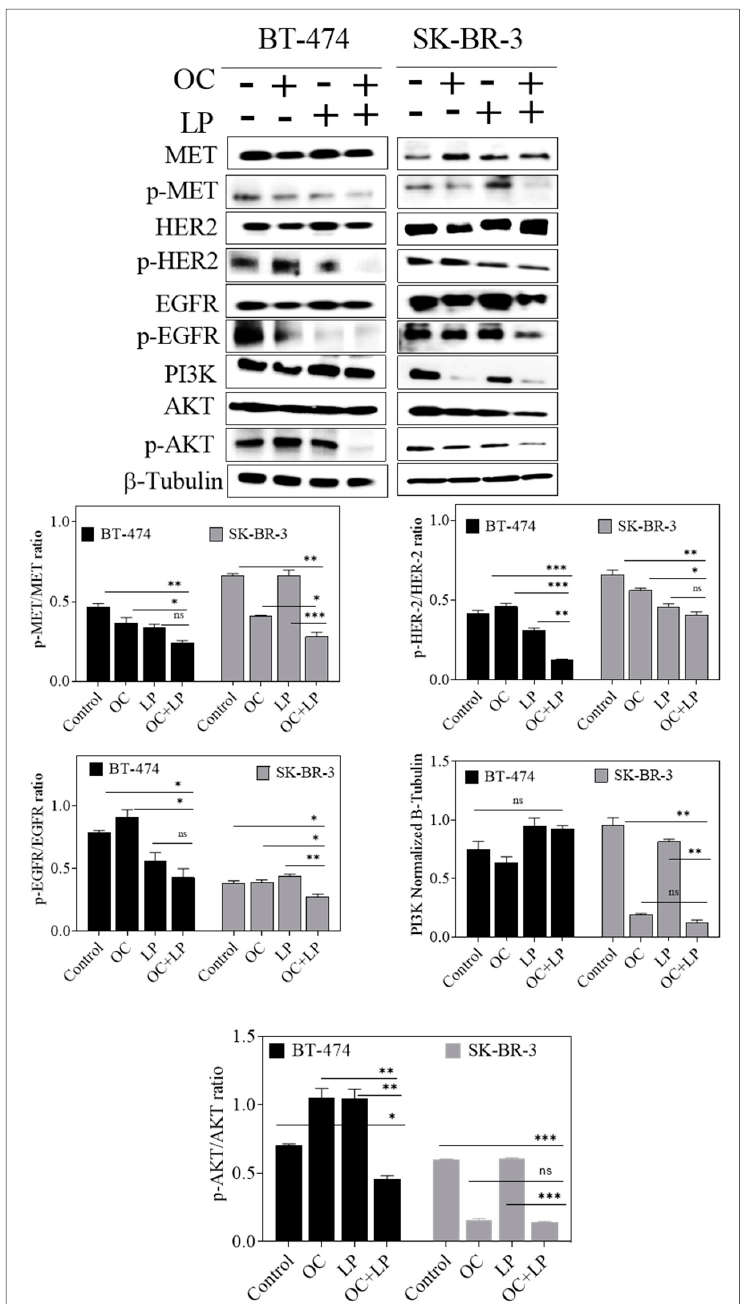
Figure 3. Effect of combined OC and LP treatment on target RTKs and downstream effectors and proliferation markers in HER2-positive BC cells. Western blot analysis for the effect of combined OC and LP treatment on RTKs, and PI3K/AKT signaling pathways. Cells were plated at 1 × 10 6 cells/100 mm culture plates in RPMI-1640 media supplemented with 10% FBS and allowed to adhere overnight. Next day, cells incubated with respective OC, LP, or combined treatment in serum-free media containing HGF and EGF 40 ng/mL as mitogens for 48 h. At the end of the treatment period, the whole cell lysates were prepared then subjected to polyacrylamide gel electrophoresis and Western blot analysis. β -Tubulin was visualized to ensure equal sample loading in each lane. Image Lab densitometric analysis performed on all blots and the integrated optical density of each band was normalized with the corresponding β -tubulin, as shown under their respective Western blot images. * p < 0.05, *** p < 0.001 as compared with either individual OC or LP treatment or vehicle